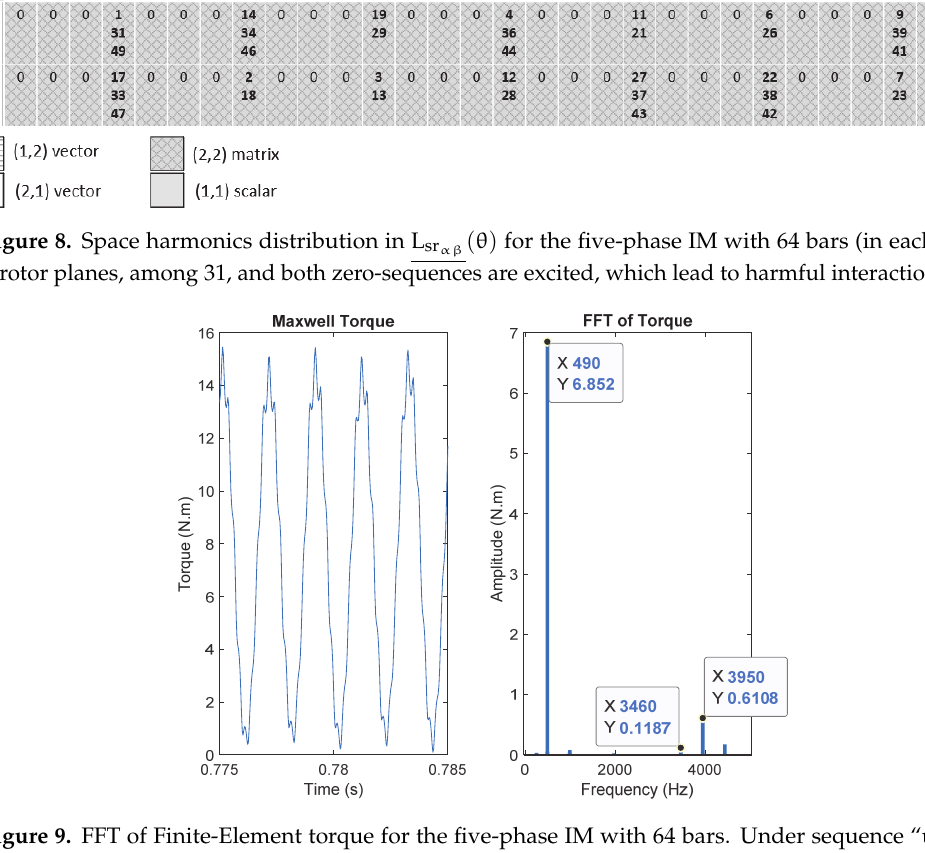
Figure 9. FFT of Finite-Element torque for the five-phase IM with 64 bars. Under sequence “u = 3” Figure 8. FFT of Finite ‐ Element torque for the five ‐ phase IM with 64 bars. Under sequence “u = 3” Table 6. Predicted torque pulsating components frequencies for the five ‐ phase IM with 64 bars (in (the planes of line (2), Figure 8 are (the planes of line (2), Figure 9 are excited). Hz). Sequence “u = 1”.